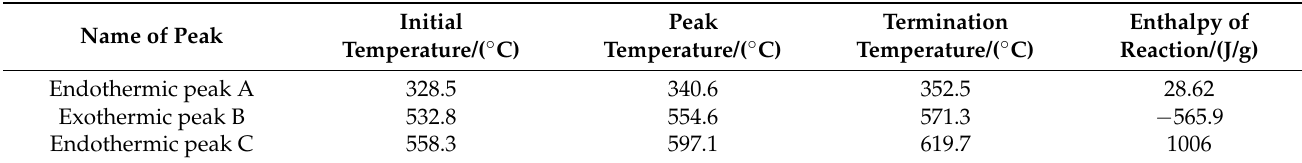
Table 15. Parameters of peak A, B and C on DSC curve of sample (PTFE/TiH 2